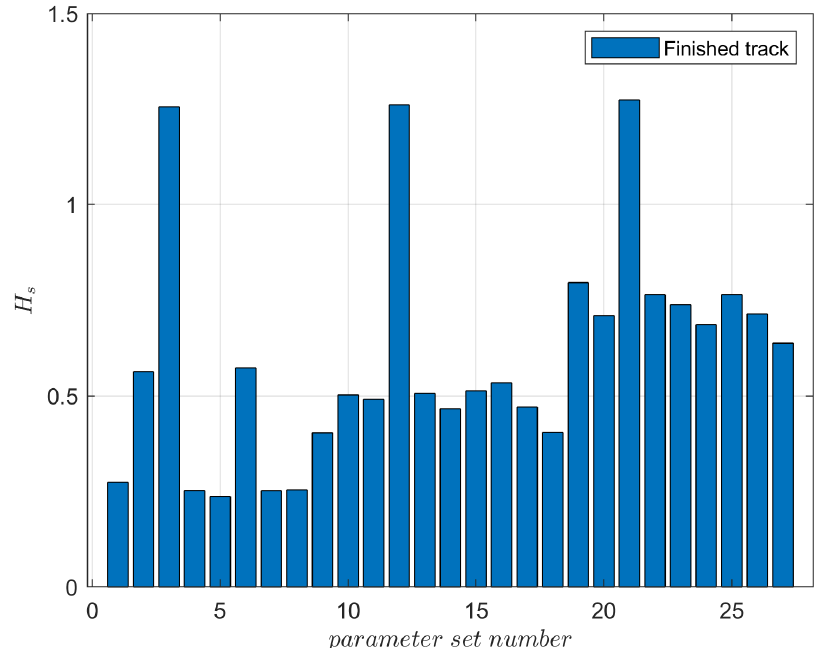
Figure 20. Path matching accuracy for the specified parameter set number—track 2.